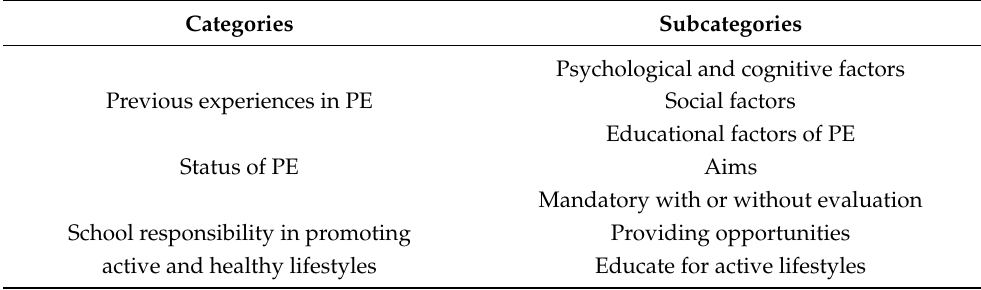
Table 2. Categories and subcategories of